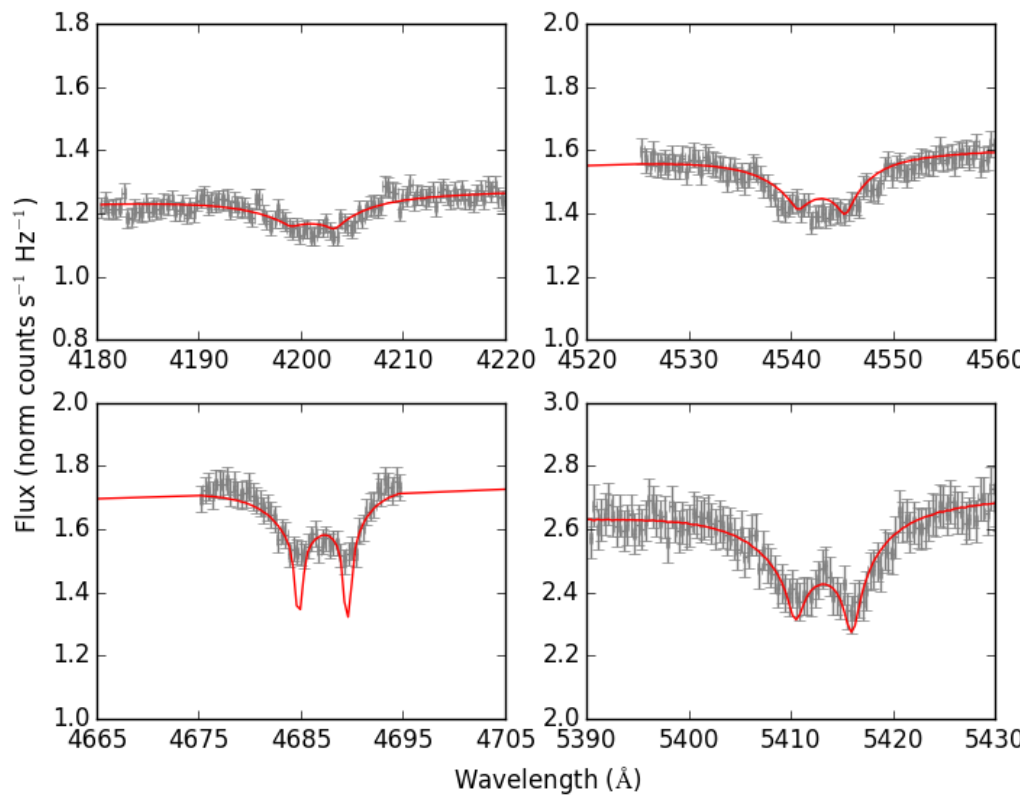
Figure 2. The model spectrum (red) plotted against the FORS2 spectrum (grey) of Hen2-428for four He II lines. The model has stellar tem- peratures of 53.0kK and 49.0kK , and log g of 5.25 and 4.91. Helium mass fractions are 0.27 and 0.24 respectively.